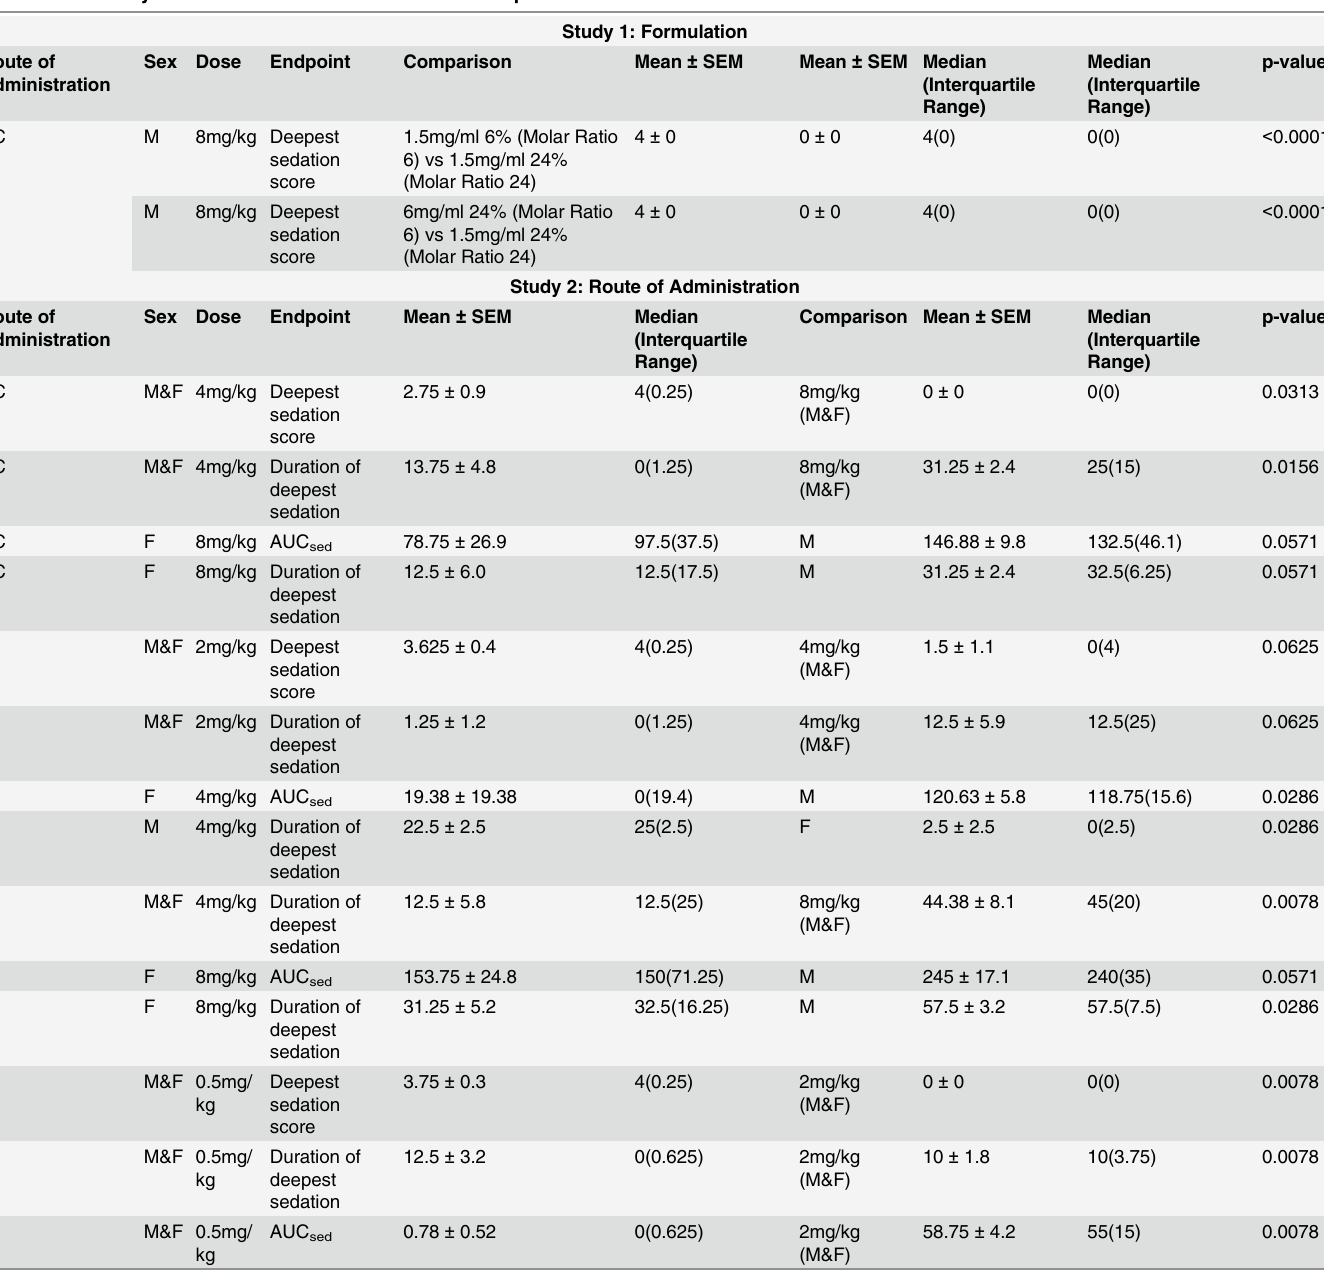
Table 3. Summary of rat sedation data and statistical comparisons.